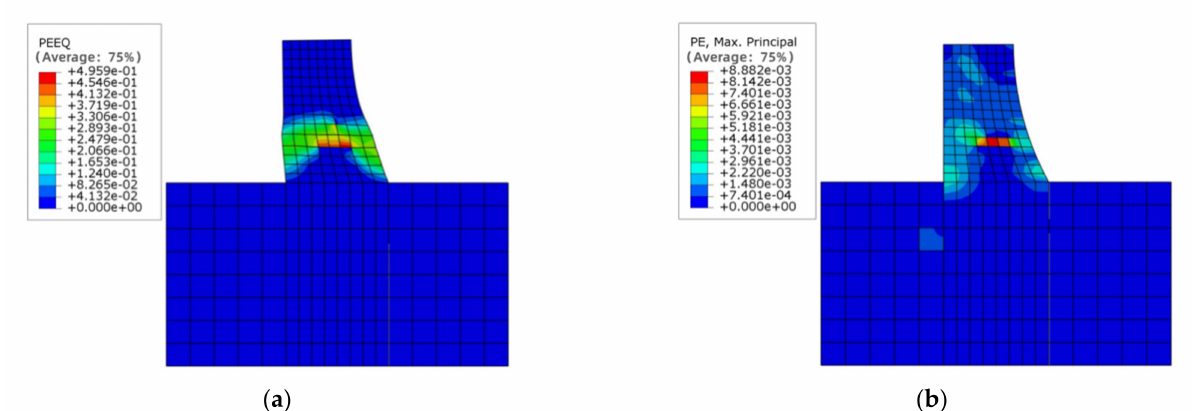
Figure 19. Cloud image of concrete plastic strain. ( a ) Cloud image of equivalent plastic compressive strain. ( b ) Cloud image of maximum principal plastic strain.